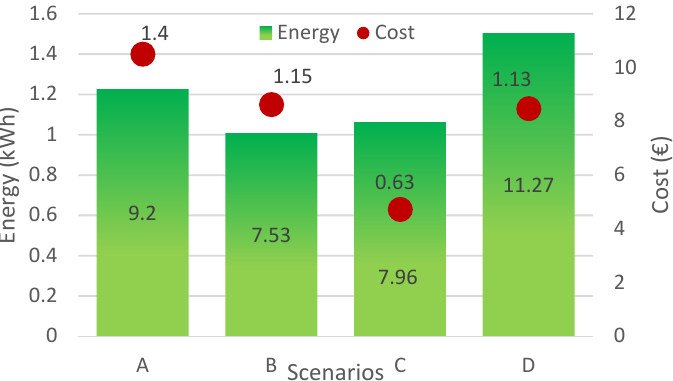
Figure 13. Summary of energy consumption and costs for Tests A to C and scenario D.